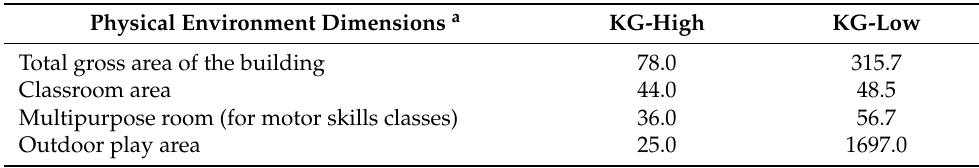
Table 2. Characterization of the kindergarten physical environment indoor and outdoor